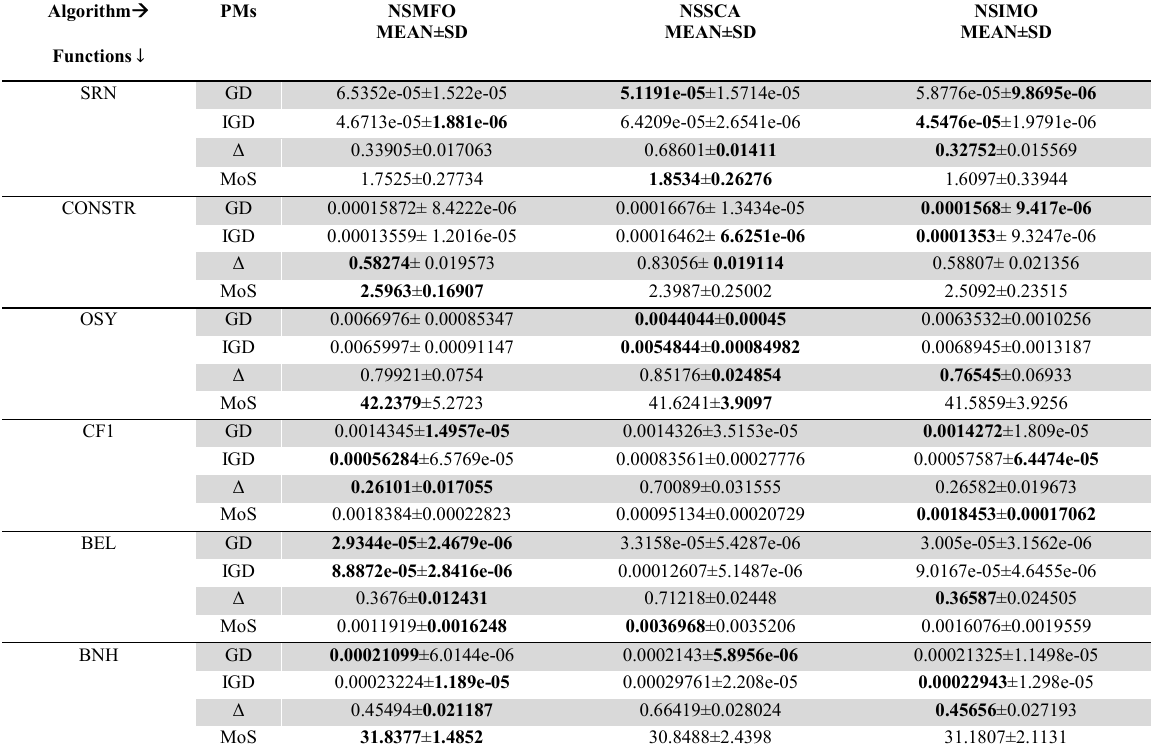
Fig. 7. Best Pareto optimal front of KUR, FON, ZDT1, ZDT2, ZDT3, ZDT4, SCHN1 and SCHN2 obtained by the NSMFO, NSSCA, and NSIMO Results (IGD, Metric of Spread, GD, and Metric of Spacing) on Constrained Multi-Objective